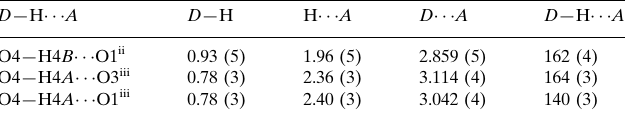
Hydrogen-bond geometry (A˚ , (cid:2)